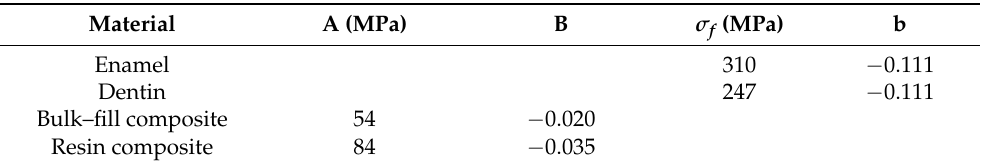
Table 1. Coefficient and exponent constants of fatigue curves of dental materials and tooth tissues [30,33–36].